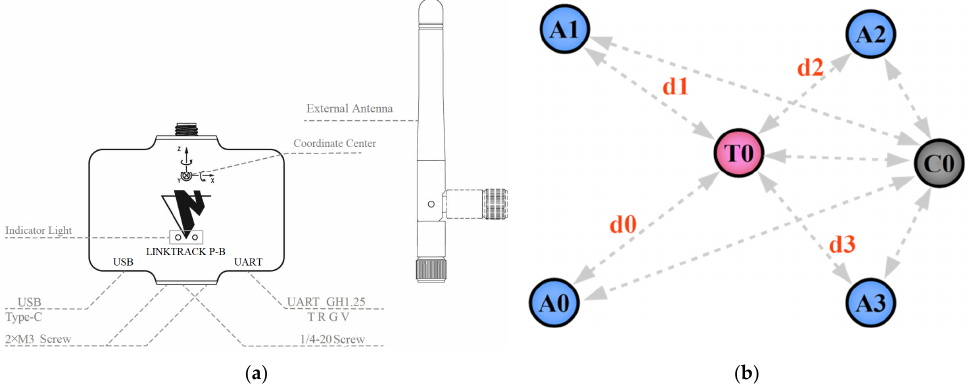
Figure 3. ( a ) Structural diagram of anchor; ( b ) Local positioning working mechanism. The A0 to A3 represent four anchors, T0 is a tag, and C0 denotes a console. The d0 to d3 represent the distance between two